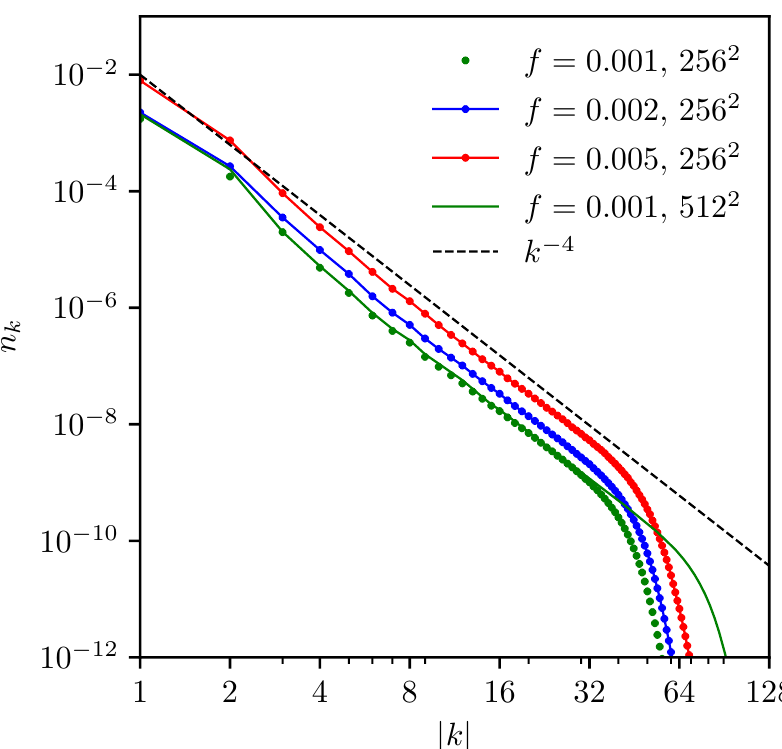
Figure 1. Stationary angle-averaged spectra for different force amplitudes f .